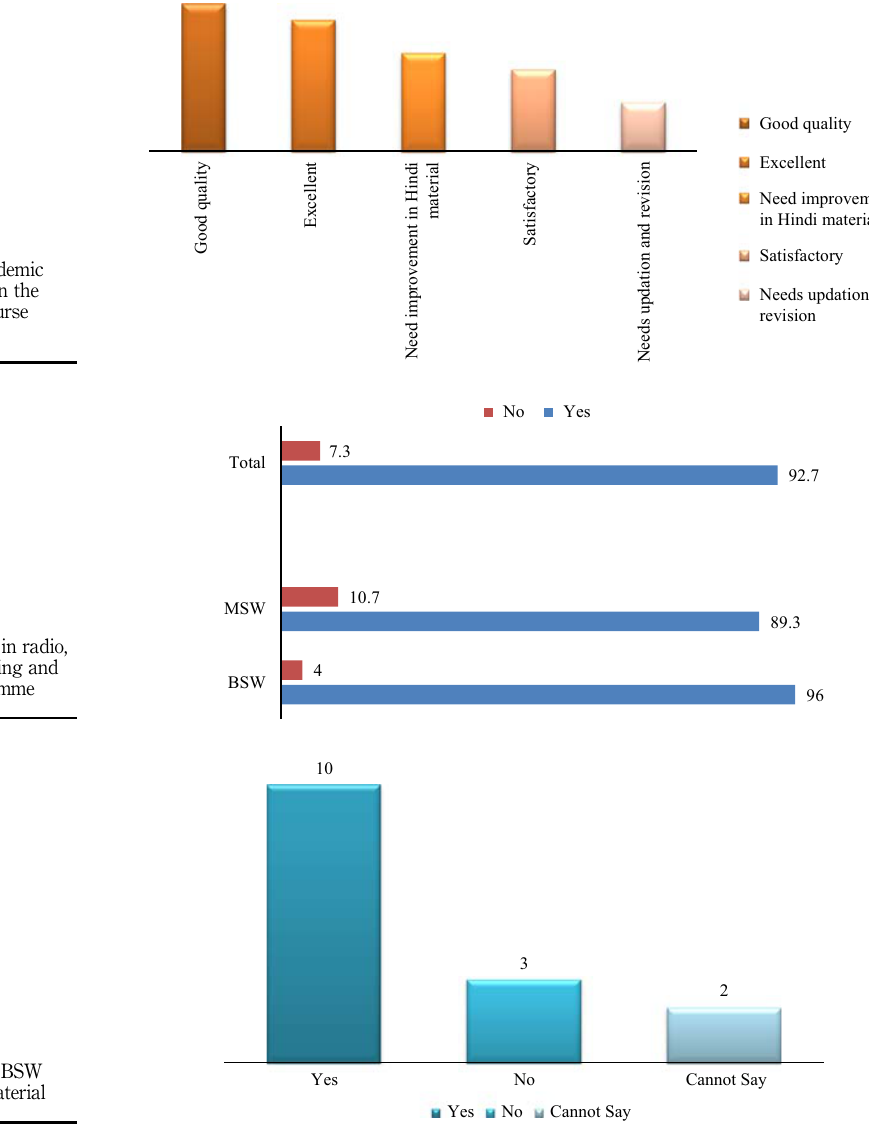
Figure 11. Difference in BSW and MSW